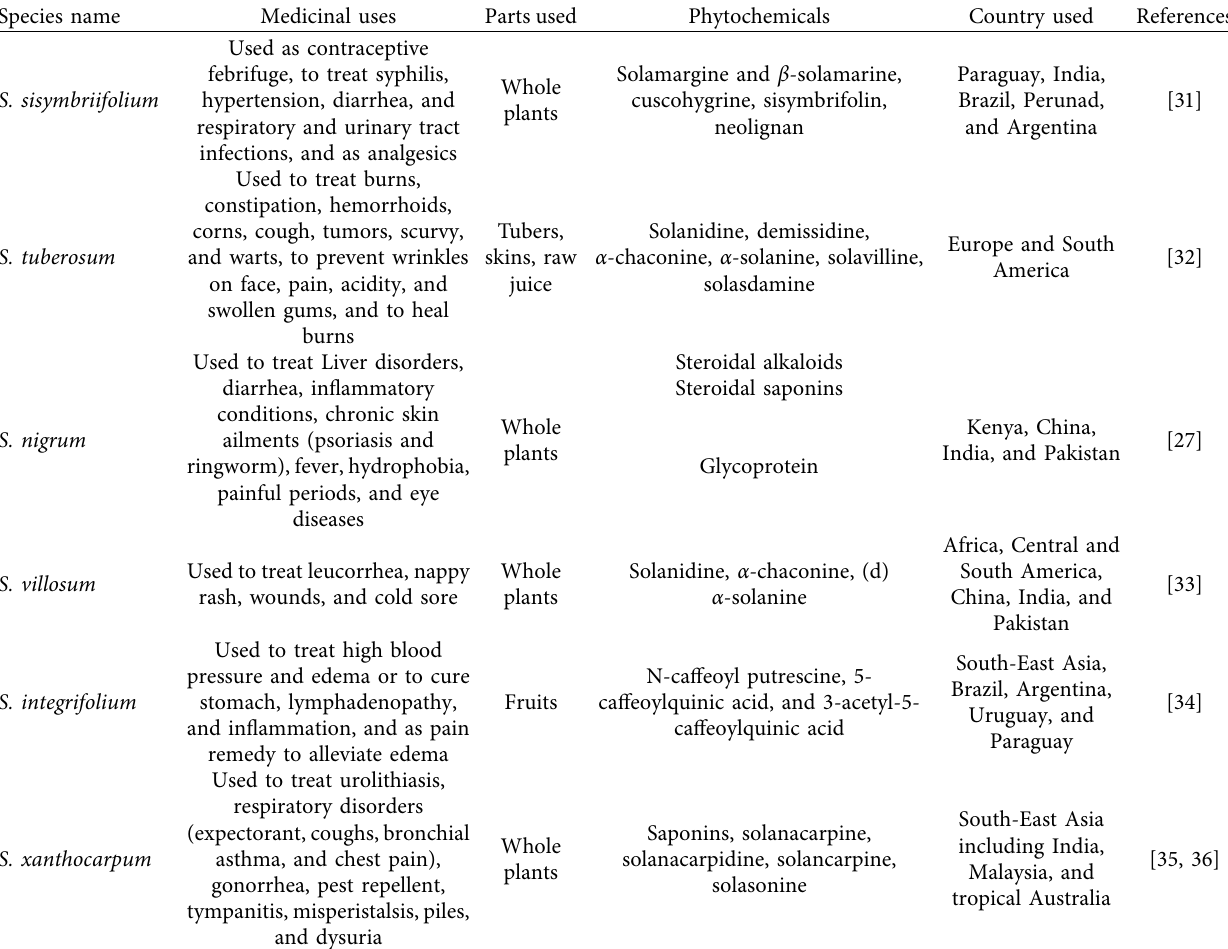
Table 3: List of various phytochemicals and ethnopharmacological uses from Solanum